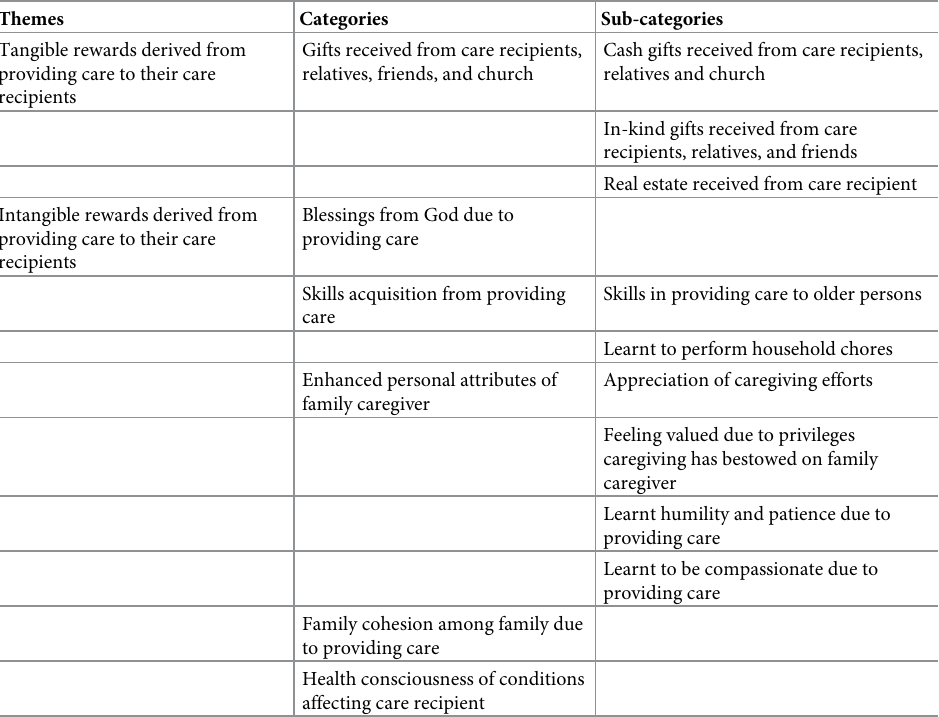
Table 4. Themes, categories and